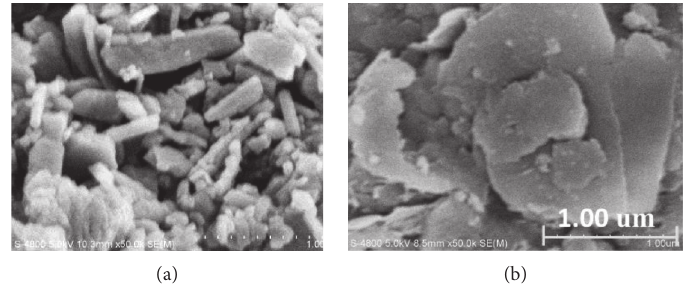
Figure 3: SEM image of the testing materials: (a) coral mud and (b) Taizhou soil.